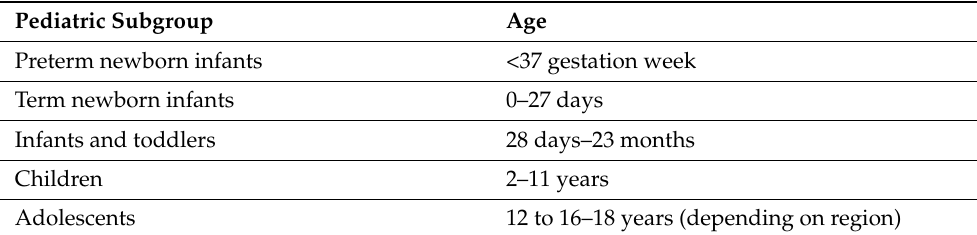
Table 5. Pediatric population subgroups according to the International Conference on Harmonisa- tion/Committee for Medicinal Products for Human Use